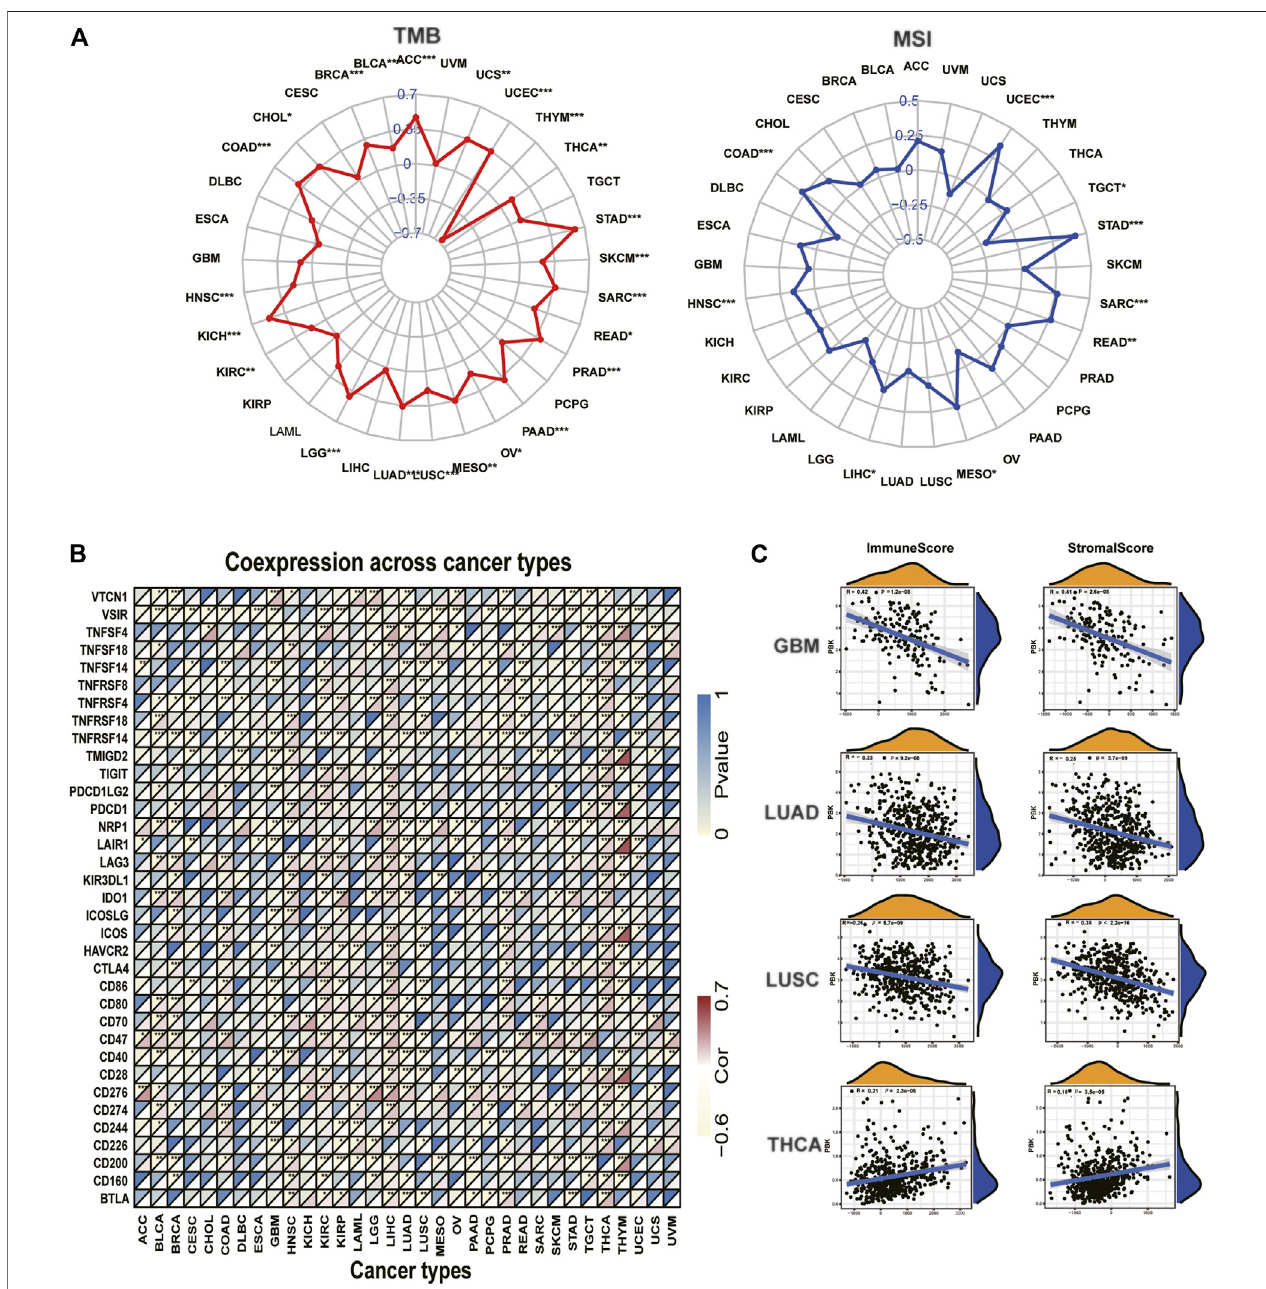
FIGURE8|| Correlation ofPBKexpression and theTMB, MSI,and tumor immune microenvironment. (A) Radar graphsofcorrelationofPBK withTMB. (B) Radar graphsofcorrelationofPBKwithMSI.Thecoordinatevaluecorrespondingtoeachpointisthecorrelationcoef fi cient.(*** p < 0.001;** p < 0.01;* p < 0.05). (C) Correlation of PBK with the immune score and the stromal